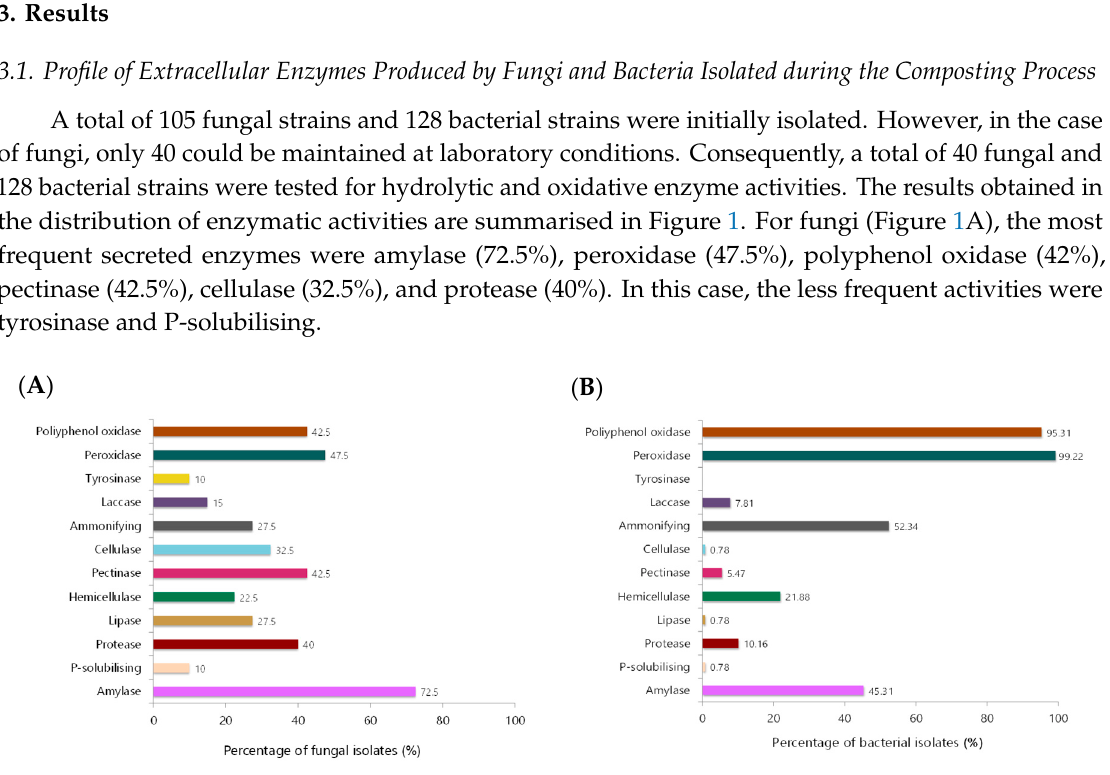
Figure 1. Percentage of enzymes produced by ( A ) fungal and ( B ) bacterial isolates.